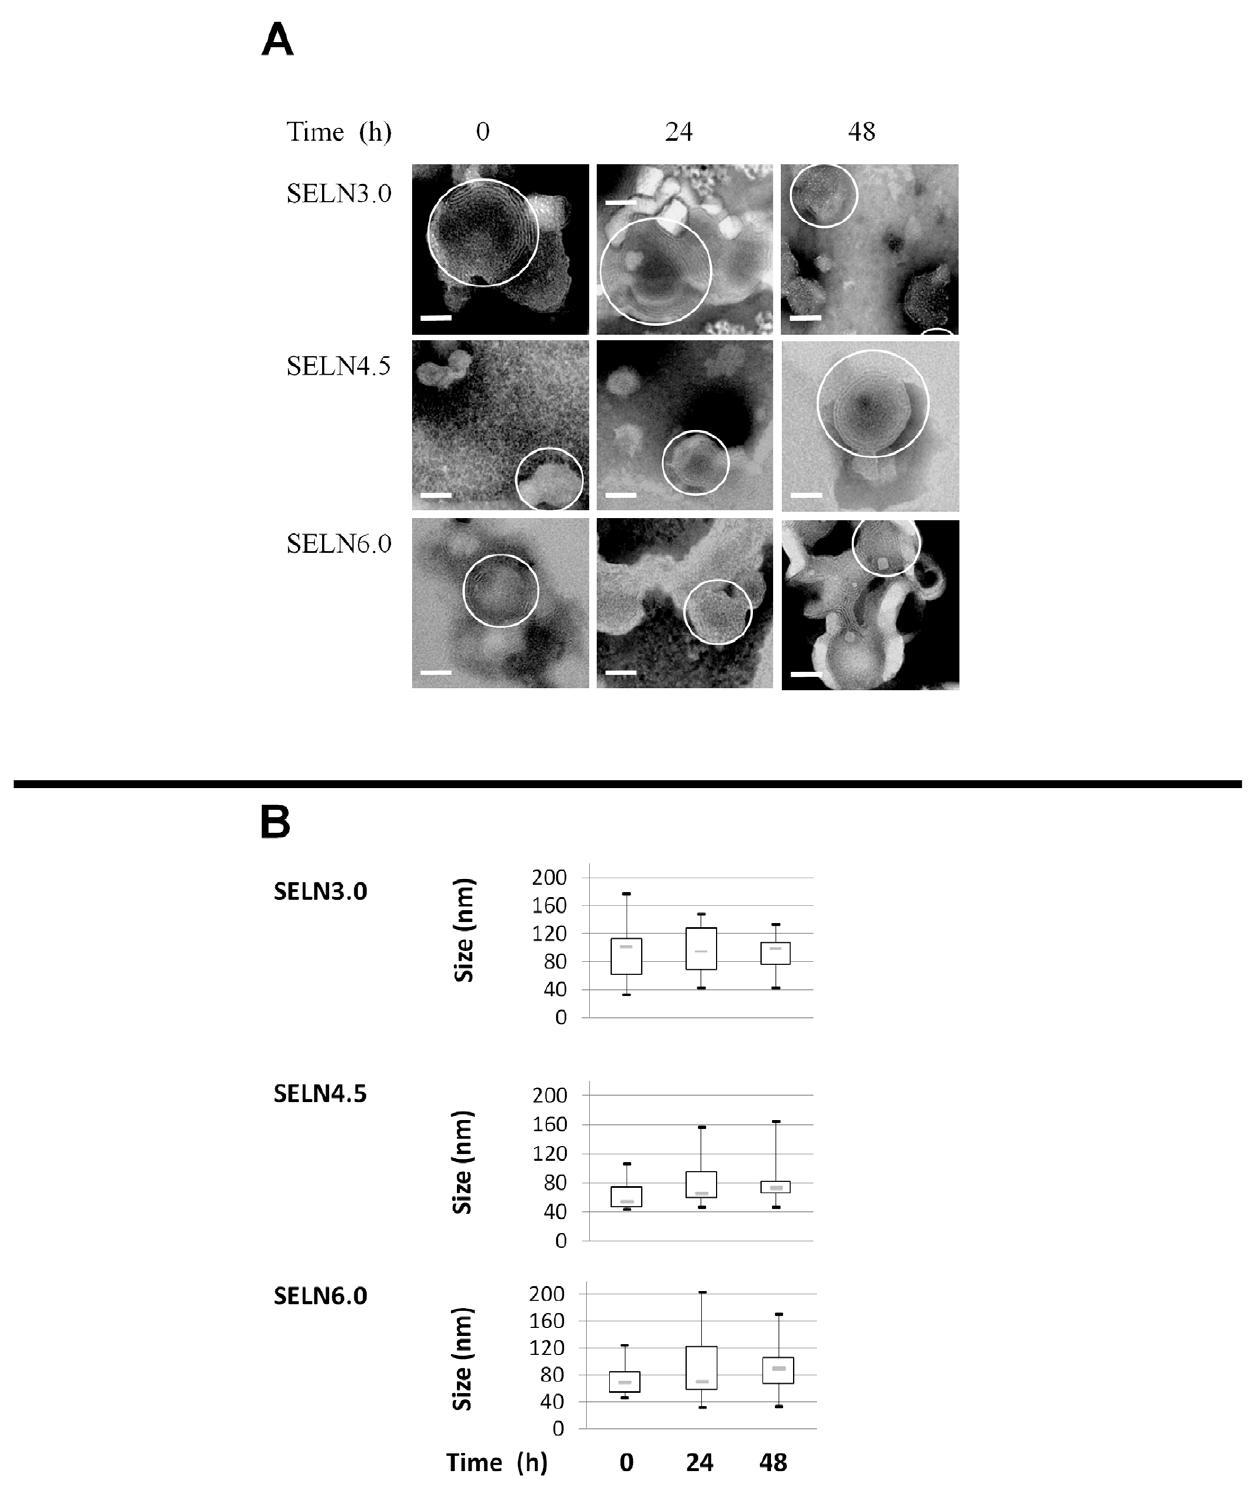
Figure 1. Synthetic exosome-like nanoparticles (SELN). (A) Synthetic exosome-like nanoparticles (SELN) were examined by electron microscopy. SELN3.0, SELN4.5 and SELN6.0 preparations were incubated at room temperature, then 3 m l were removed at 0, 24 h and 48 h. SELN were then disposed on top of Formvar-coated 300-mesh carbon grids and treated with 2% phosphotungstic acid. Several fields were photographed and used to determine the diameter of SELN. Scale bars on microphotographs represent 50 nm. (B) The range of observed diameters for lipid structures as represented in A was statistically represented by the box plot. The dashed line inside the box represents the median diameter of SELN (n=20). The box represents the interquartile range (50% of values). Tails extend to values within 1.5 times the interquartile range.